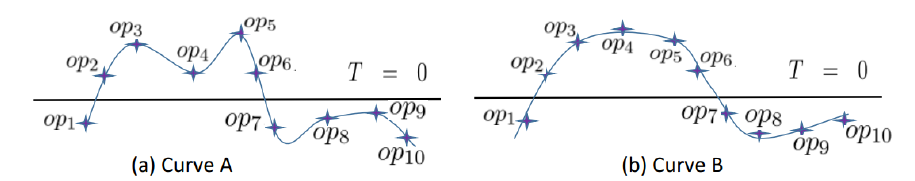
Figure 3. This figure is used to explain why cyclic binary encoding method (in Equation (7)) is better than mean binary encoding method (in Equation (4)). We sampled 10 times on two different curves (Curve A and Curve B) and got 10 sample values. Then we use different binary encoding methods to encode the sample values in order to compare the results of coding methods. Because the two curves are different from each other, we expect to obtain different binary-coding bits-string.